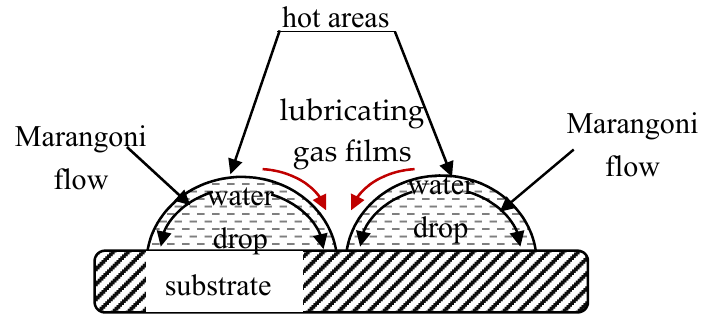
Figure 5. Scheme of non-coalescence of sessile droplets is depicted (see [147,148] for details).